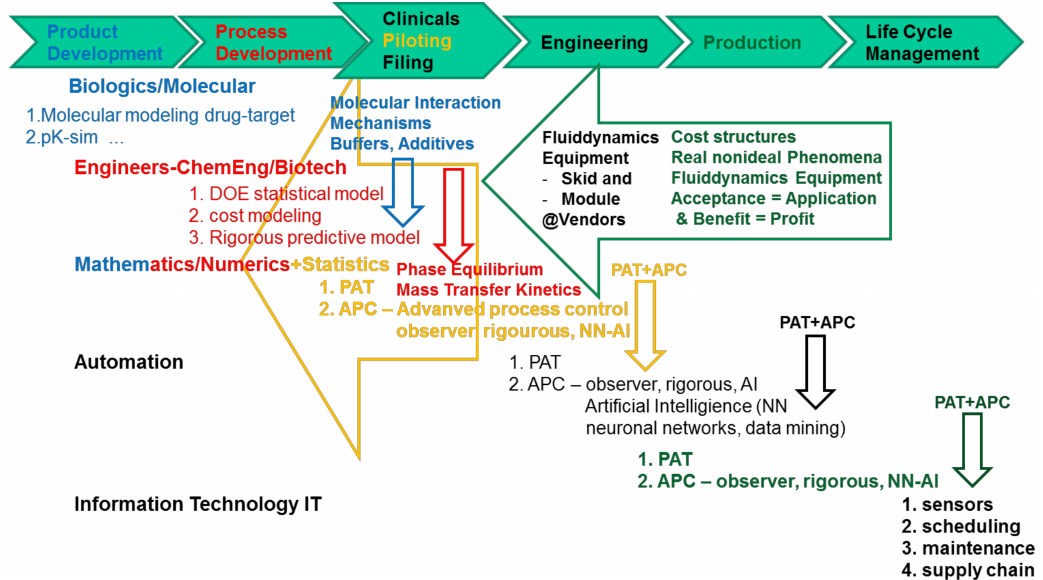
Figure 1. Overview of modeling types in different stages of process development and life